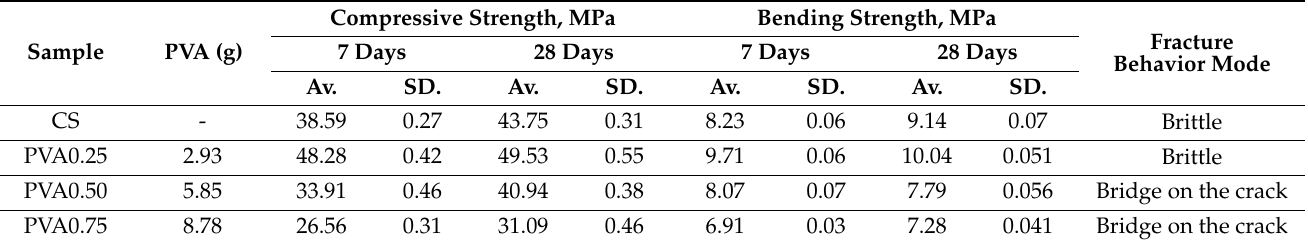
Table 9. Compressive and bending strengths of mortar containing PVA.